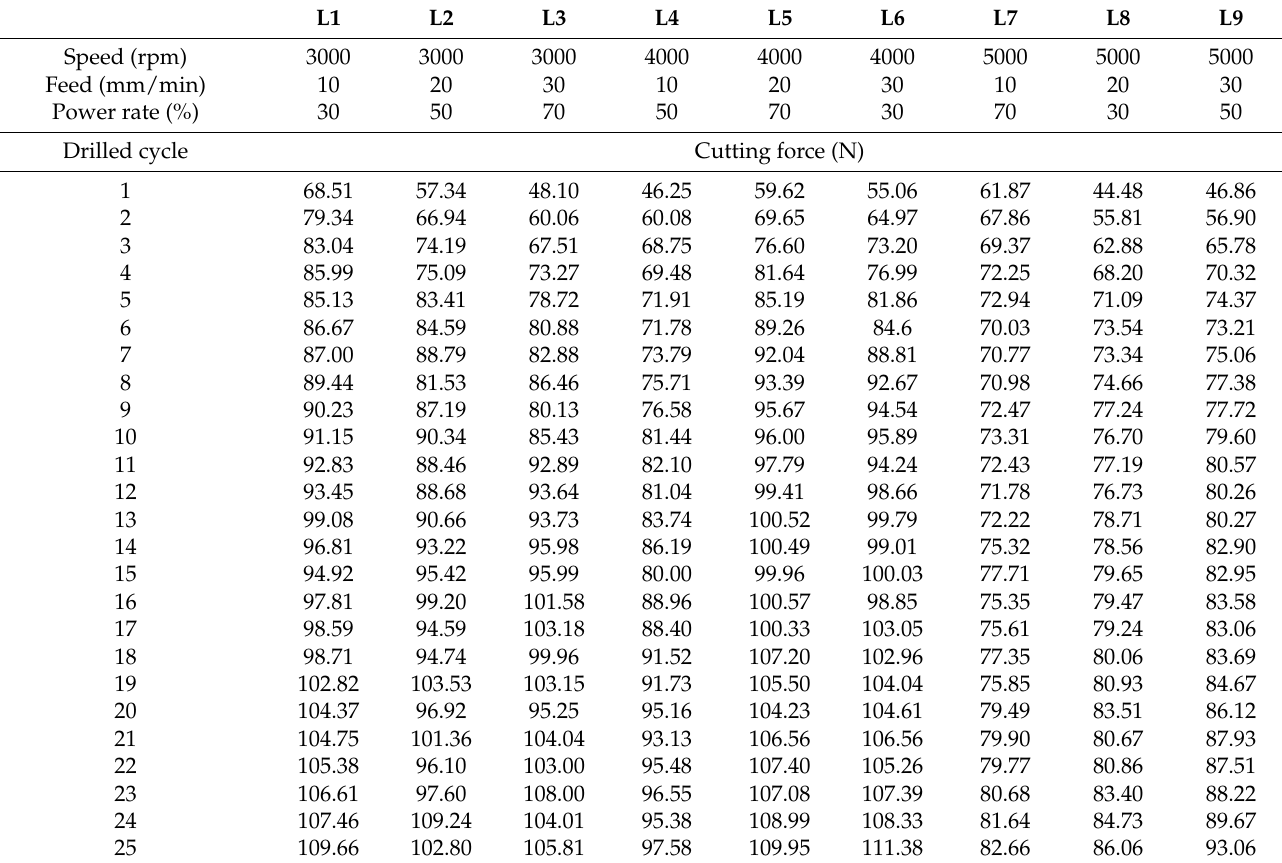
Table 2. Cutting forces measured under different process